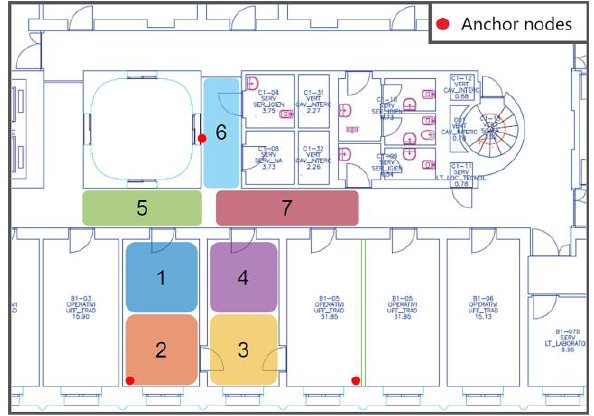
Figure 5. Test site map. The seven areas for the first experiment are highlighted. The red dots represent the anchor nodes.